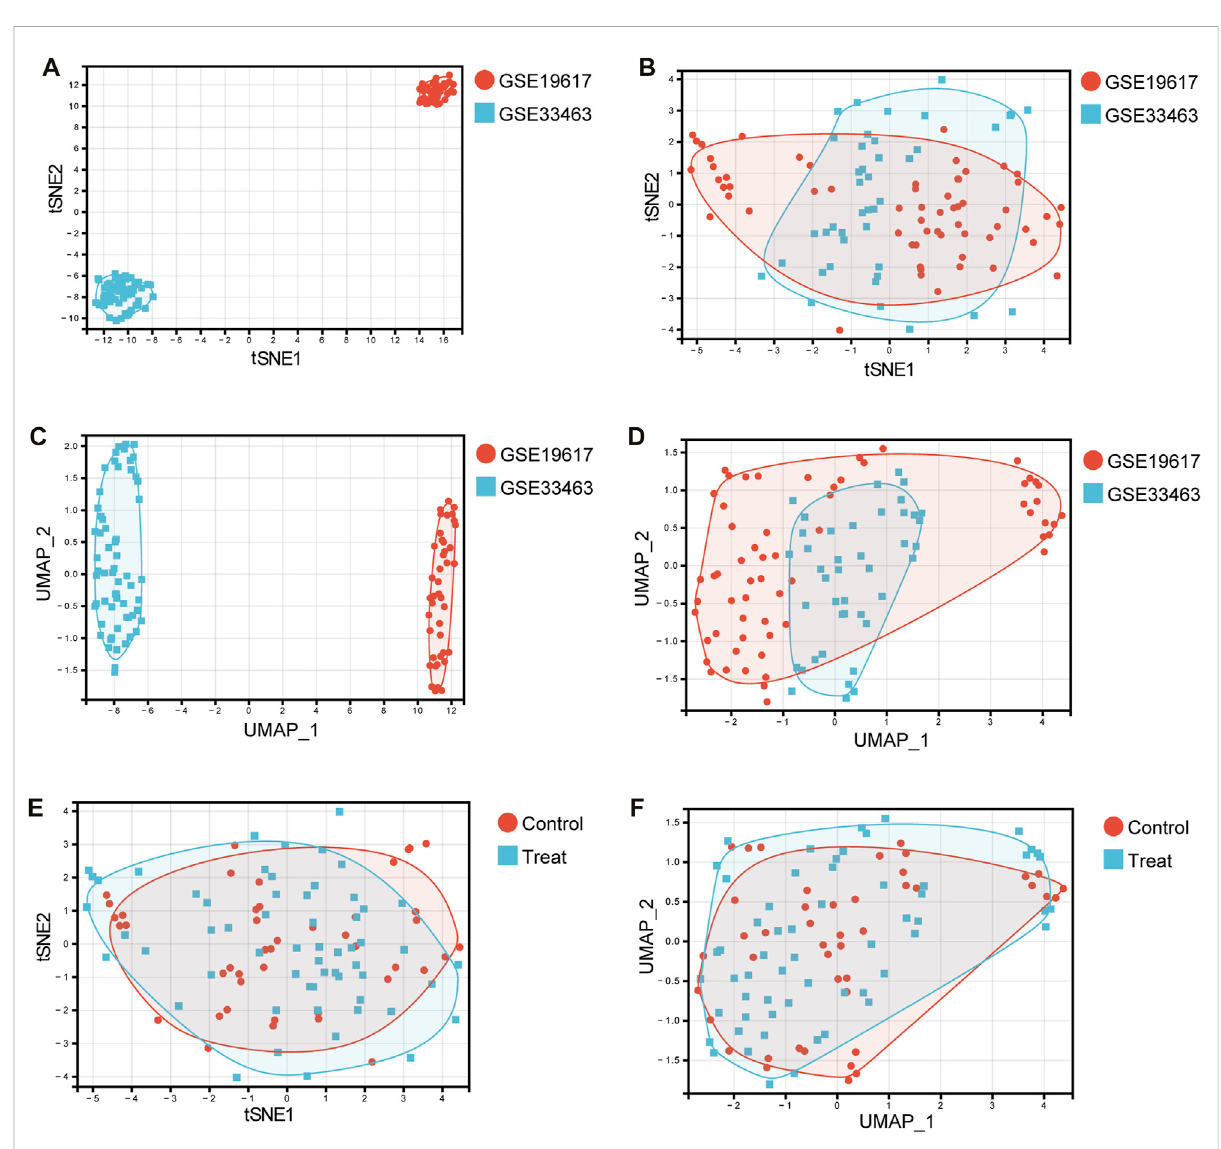
FIGURE 1 Dimensionality reduction using tSNE and UMAP. (A) The tSNE plot before removal of the batch effect. Red dots represent samples in the GSE19617 dataset, and blue squares represent samples in the GSE33463 dataset. (B) The tSNE plot after removal of the batch effect. Red dots represent samples in the GSE19617 dataset, and blue squares represent samples in the GSE33463 dataset. (C) The UMAP plot before removal of the batch effect. Red dots represent samples in the GSE19617 dataset, and blue squares represent samples in the GSE33463 dataset. (D) The UMAP plot after removal of the batch effect. Red dots represent samples in the GSE19617 dataset, and blue squares represent samples in the GSE33463 dataset. (E) The tSNE plot of the control and treatment group samples. Red dots represent control group samples, and blue squares represent treatment group samples. (F) The UMAP plot of the control and treatment group samples. Red dots represent control group samples, and blue squares represent treatment group